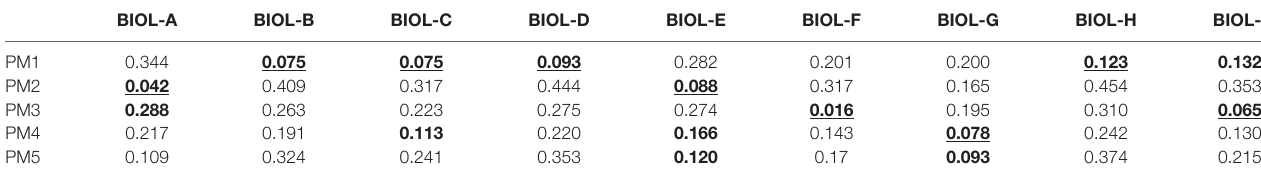
Table 4 | Euclidean distances between barycenters of Biology panel members and individual research groups using 2-dimensional base map of Web of Science Subject Categories.